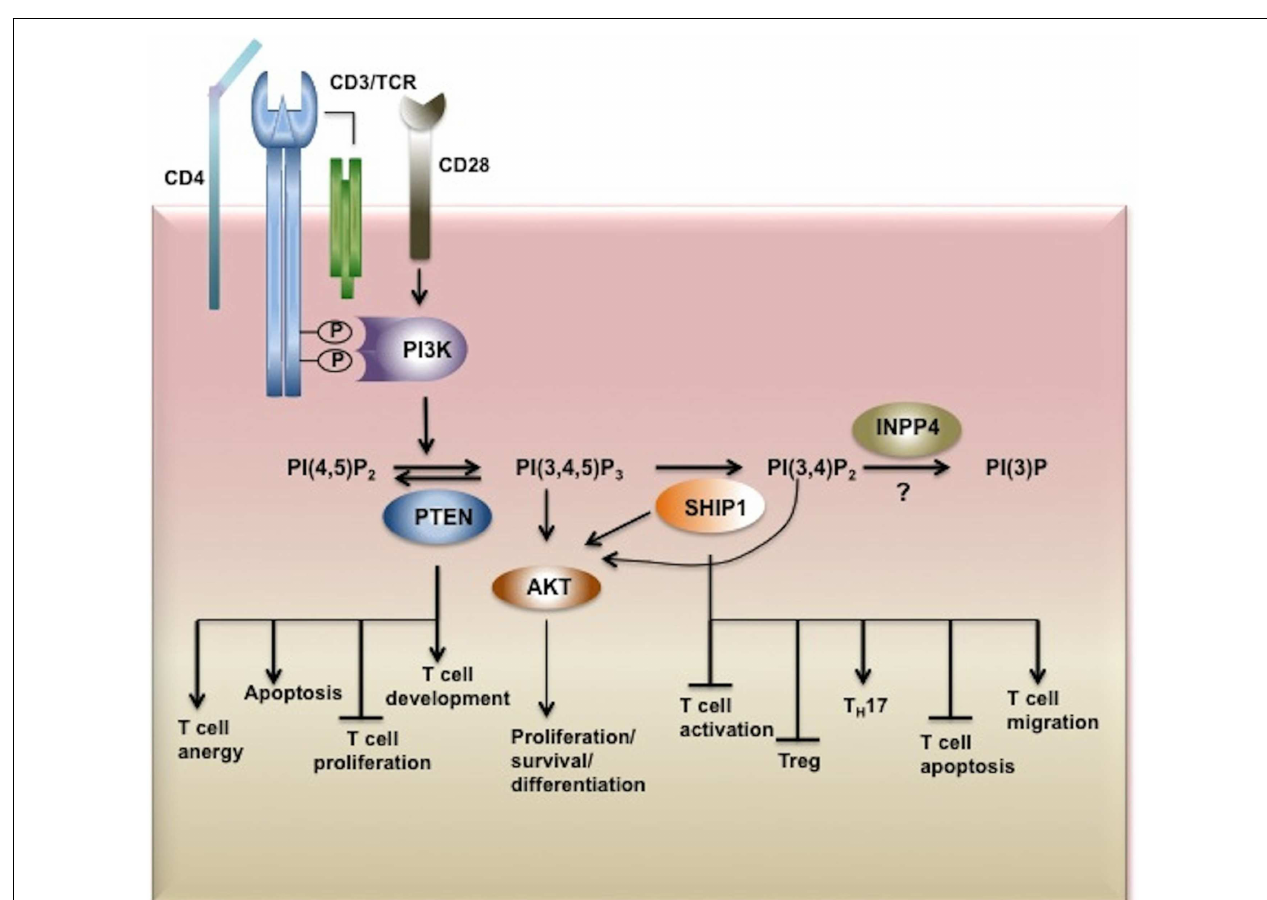
PI(3,4,)P 2 and PI(4,5)P 2 , respectively. By limiting the cellular pool of the second messenger PI(3,4,5)P 3 , PTEN and SHIP play important functions inT cell development, proliferation, and activation.The SHIP1 product PI(3,4)P 2 which can also recruit and activate AKT is dephosphorylated by INPP4. However the role of these 4-phosphatases inT cell biology has yet to be determined. AKT, Protein Kinase B; PDK1, phosphoinositide-dependent kinase-1, PLC γ phospholipase C γ ; ITK, IL-2-inducibleT cell kinase) and BTK, Bruton agammaglobulinemia tyrosine